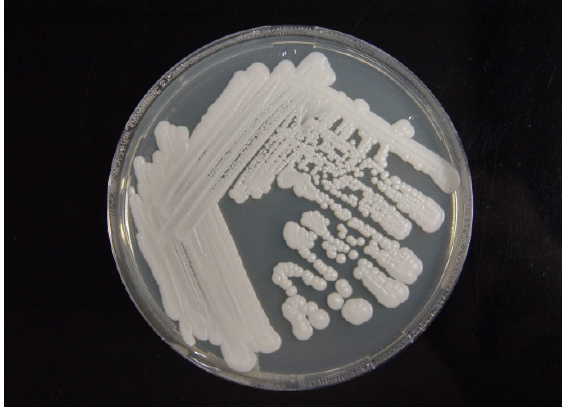
Figure 3. Culture of C. palmioleophila isolated from the blood and grown on potato dextrose agar at 25 °C for 14 days.